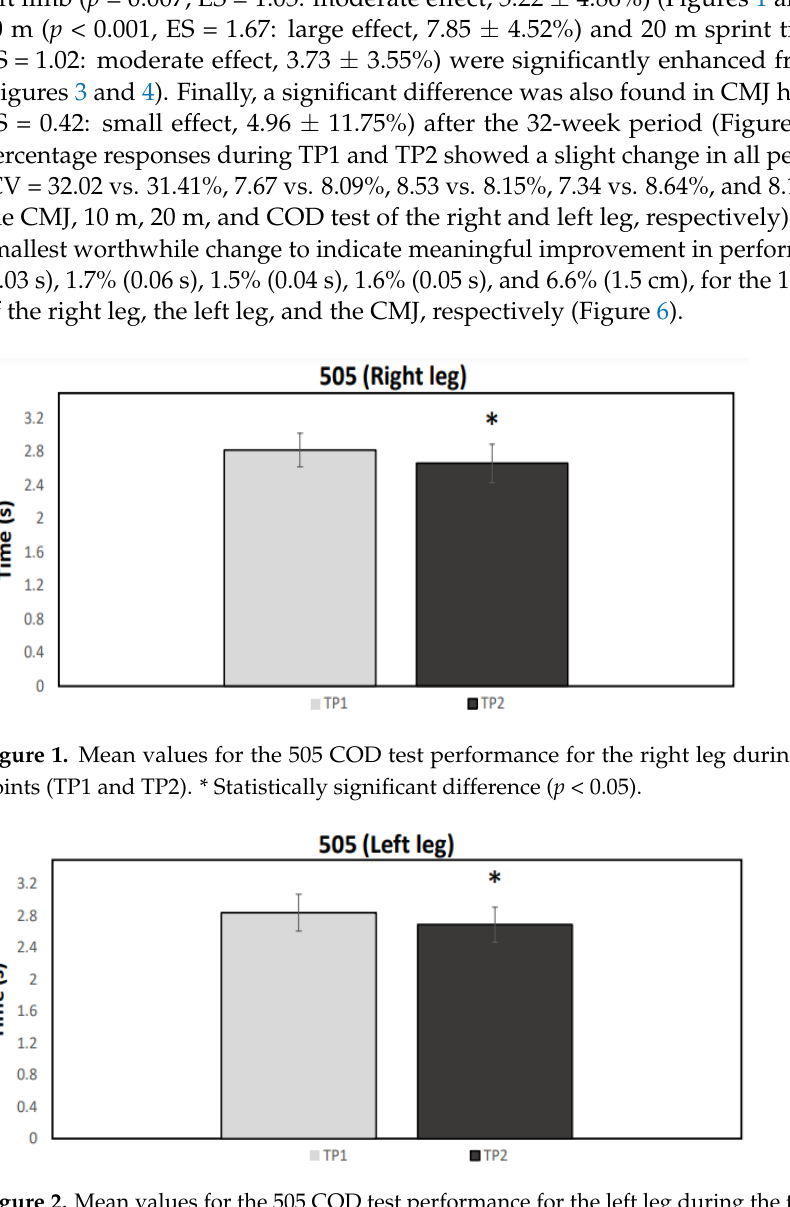
Figure 3. Mean values for the 10-m linear sprint performance during the two testing points (TP1 and TP2). * Statistically significant difference ( p < 0.05). Figure 4. Mean values for the 20-m linear sprint performance during the two testing points (TP1 and TP2). * Statistically significant difference ( p < 0.05).